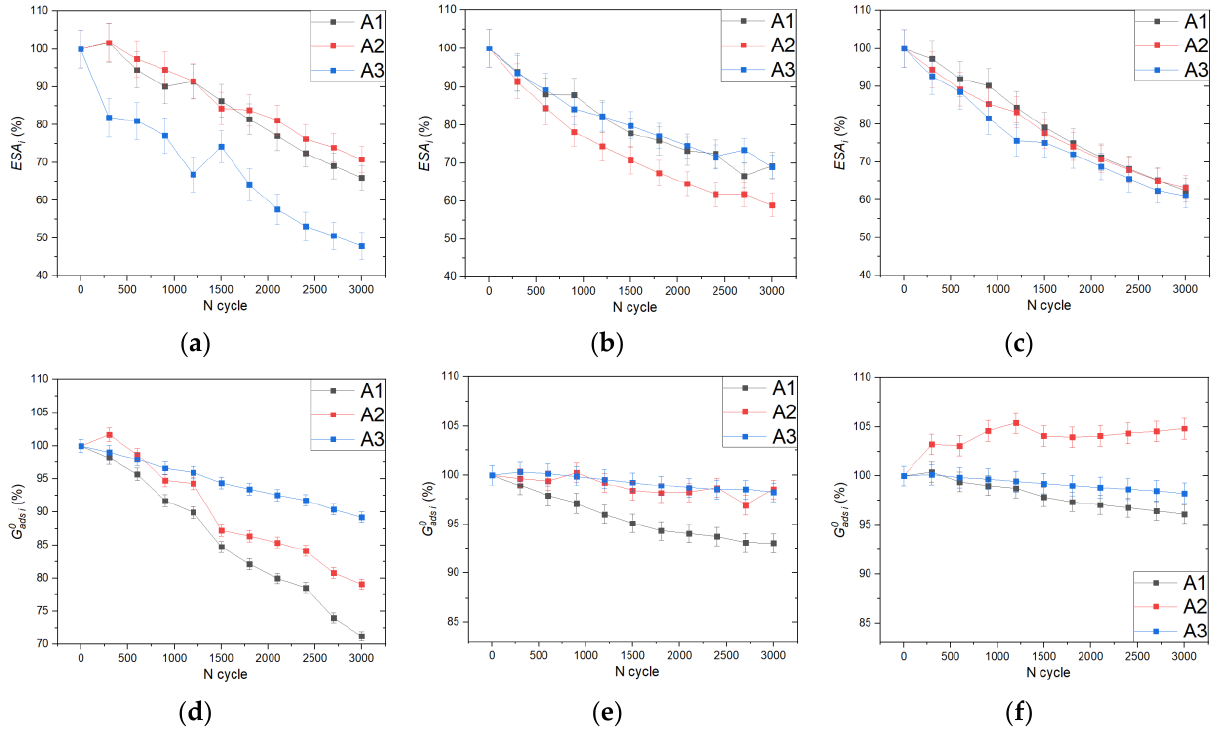
Figure 7. Variation of the ESA and adsorption energy for peaks A1, A2, and A3 normalized to initial values with an increasing number of the AST cycles for the Pt 20 /RGO ( a , d ), Pt 20 /CNF ( b , e ), and Pt 20 /CNT ( c , f ) samples. The trends obtained characterize the stability of the electrocatalysts based on complex carbon nanostructures and changes in the structure of platinum nanoparticles during the AST cycles.